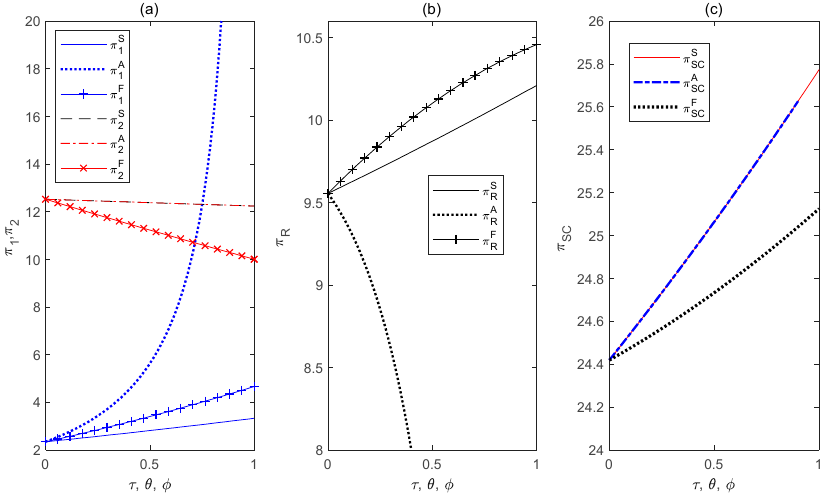
Figure 3. ( a ) Effect of retailer’s CSR practice on π 1 and π 2 . ( b ) Effect of retailer’s CSR practice on π R . ( c ) Effect of retailer’s CSR practice on π SC .